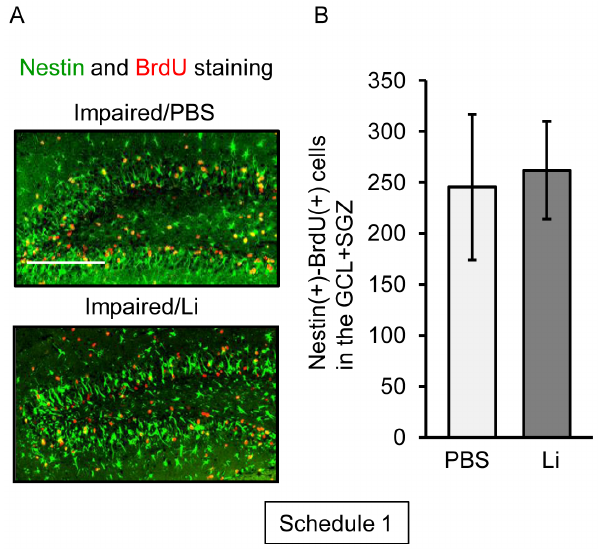
Figure 3. Effect of lithium (Li) on proliferation of nestin( + ) cells following neuronal loss. Animals were given either lithium carbonate (100 mg/kg, i.p.) or PBS alone with BrdU on day 2 post- treatment with TMT, and then decapitated on day 3 post-treatment for preparation of sagittal hippocampal sections, which were then stained with antibodies against nestin and BrdU (Schedule 1). ( a ) Fluorescence micrographs show nestin( + ) cells ( green ) and BrdU( + ) cells ( red ) in the dentate gyrus of the 2 groups (impaired/PBS, impaired/Li). Scale bar=100 m m ( b ) Graph denoting the number of nestin( + )-BrdU( + ) cells in the GCL + SGZ of each group. Values are expressed as the mean 6 S.E., calculated from 5 animals.